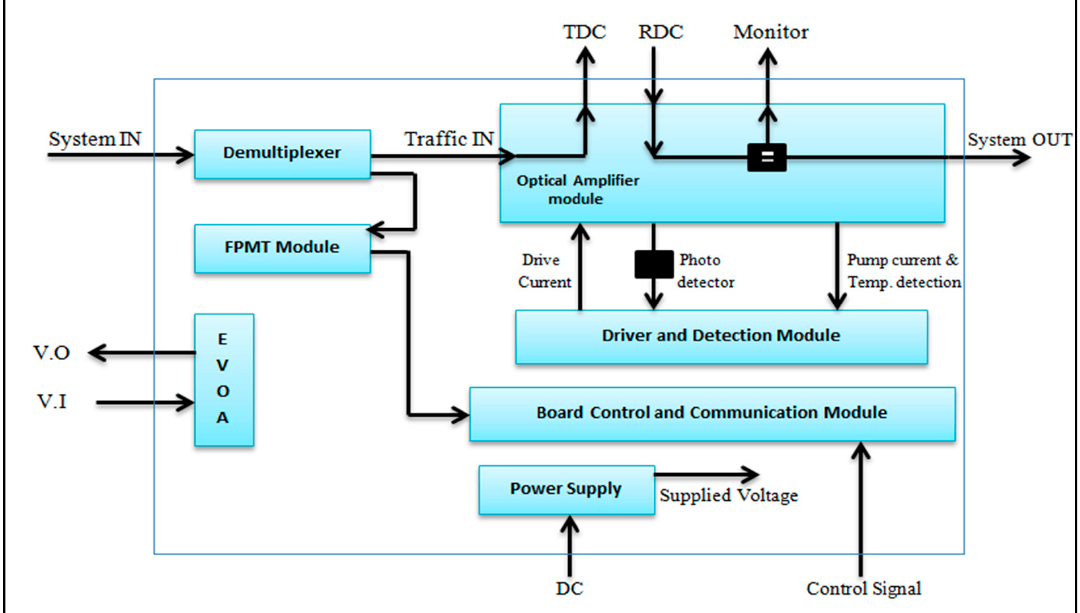
Figure 5. The optical amplifier board block diagram used in the receiving side of the DWDM system structure after adding the FPMT detection circuit.